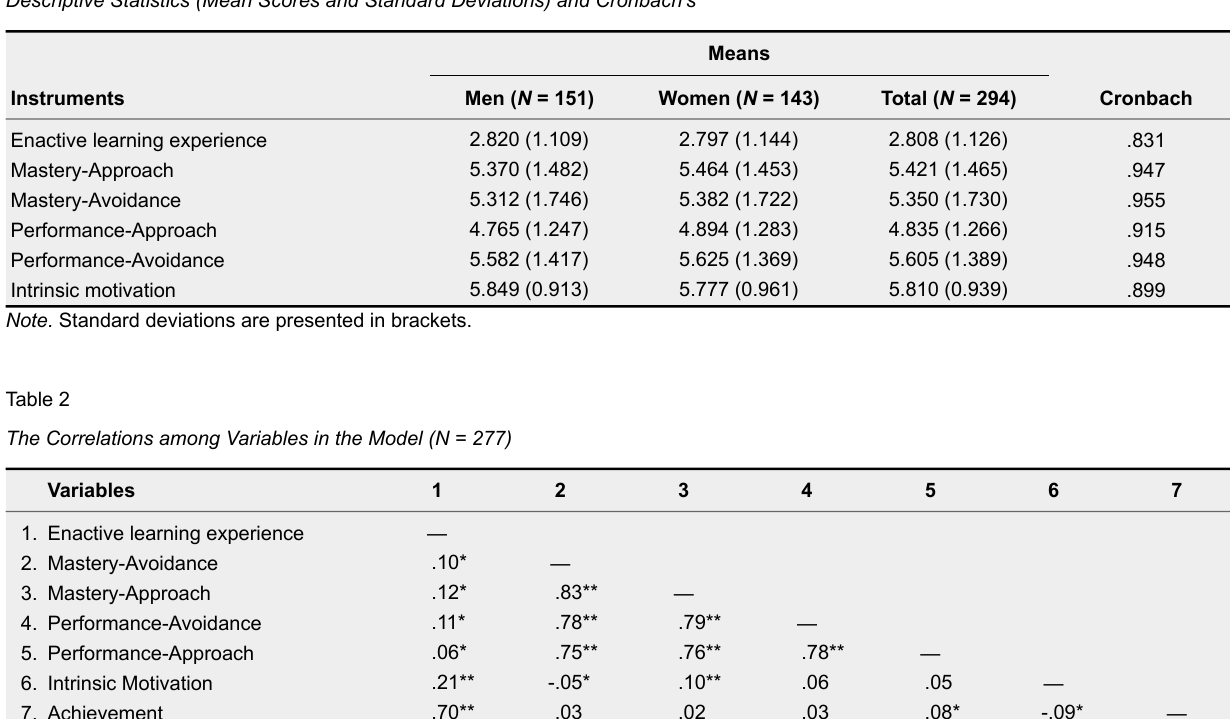
Descriptive Statistics (Mean Scores and Standard Deviations) and Cronbach’s Instruments Total ( N = 294)Women ( N = 143)Men ( N = 151) .831Enactive learning experience